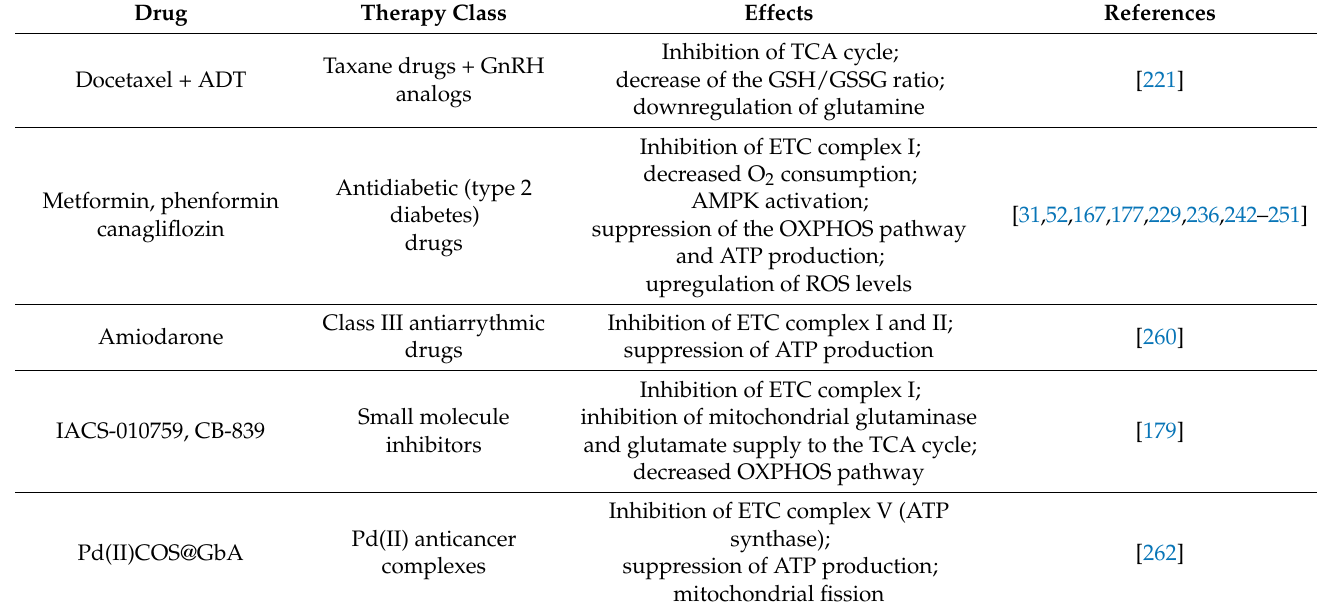
Table 1. Anticancer drugs targeting mitochondrial functional rewiring and structural dynamics in PCa